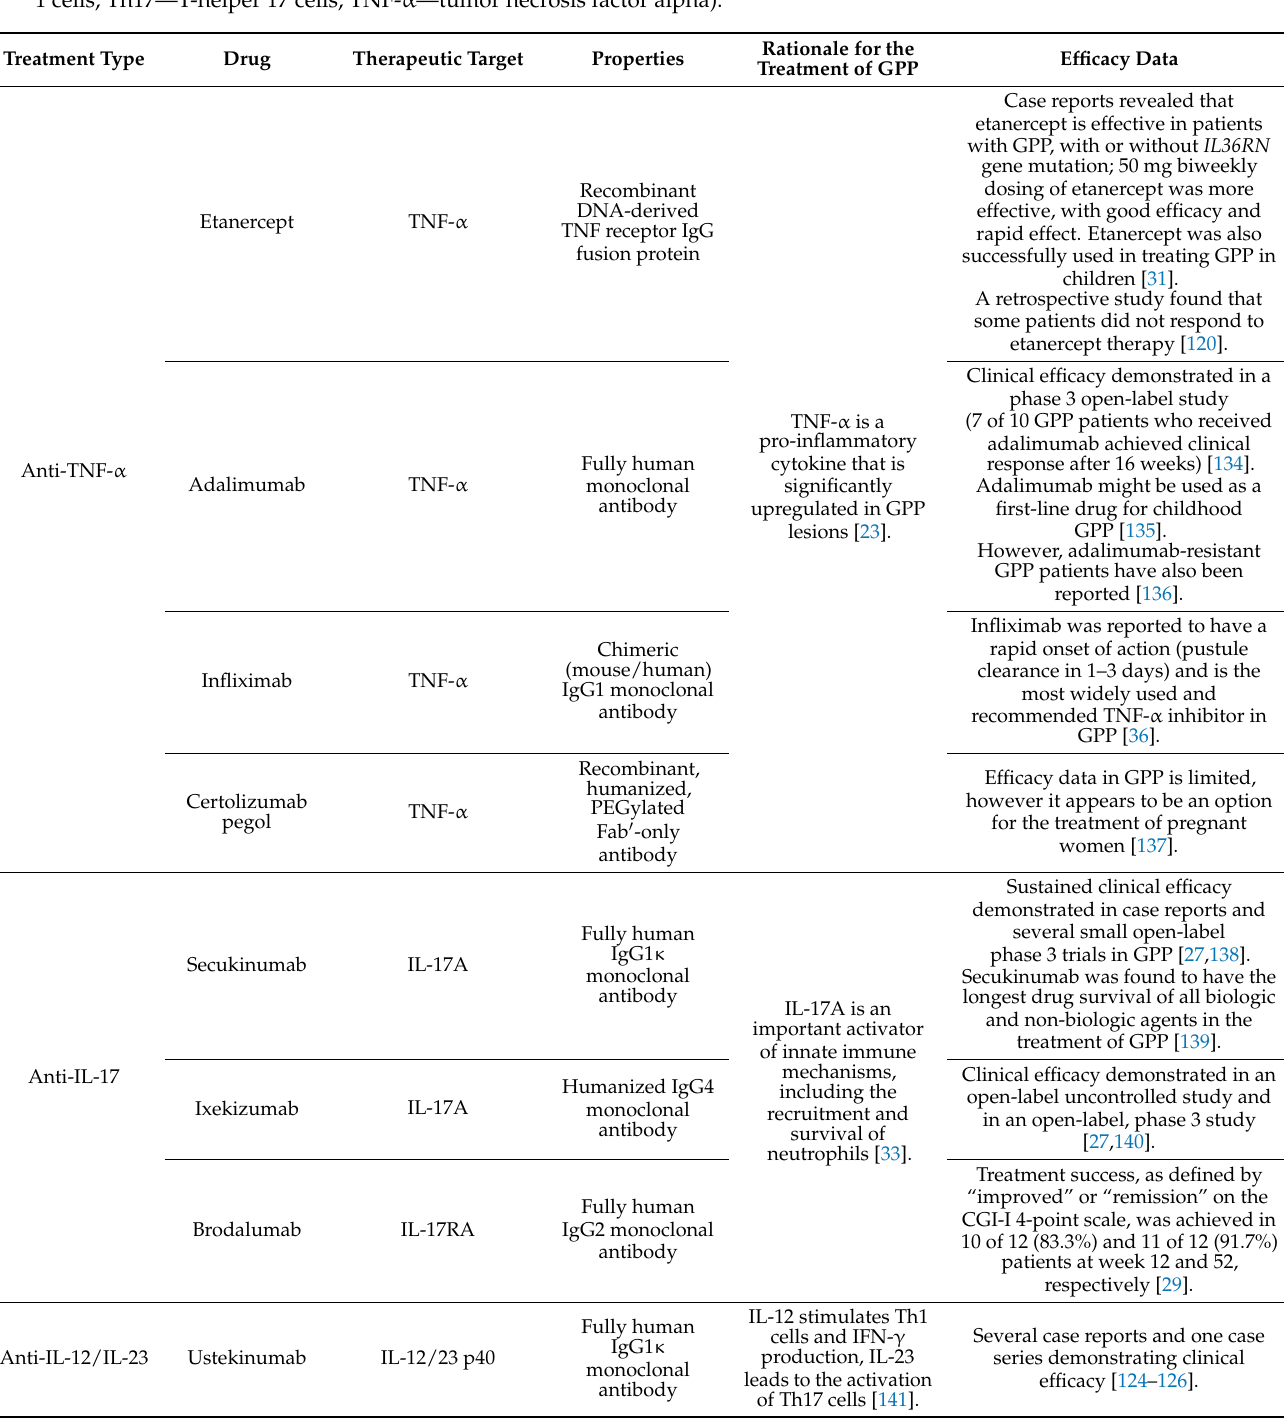
Table 2. Targeted therapies in generalized pustular psoriasis. (CD25—cluster of differentiation 25, CGI-I—clinical global impression of improvement, Fab’—humanized antigen-binding fragment, GPP—generalized pustular psori- asis, IFN- γ —interferon-gamma, IgG—immunoglobulin G, IgG1—immunoglobulin G1, IgG1 κ —immunoglobulin G1 kappa, IgG1 λ —immunoglobulin G1 lambda, IgG2—immunoglobulin G2, IgG4—immunoglobulin G4,